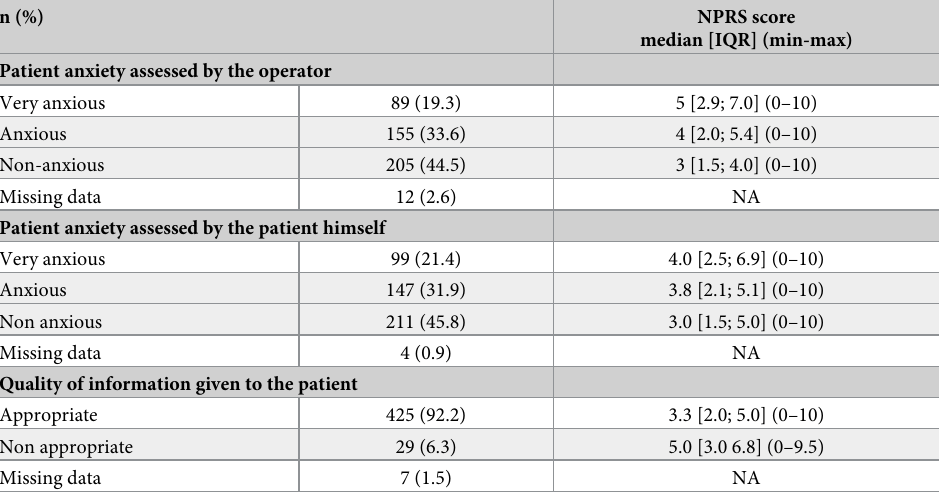
Table 3. NPRS scores in the whole cohort (n = 461) according to patient’s anxiety assessed by the operator or by the patient himself, and according to the quality of information.